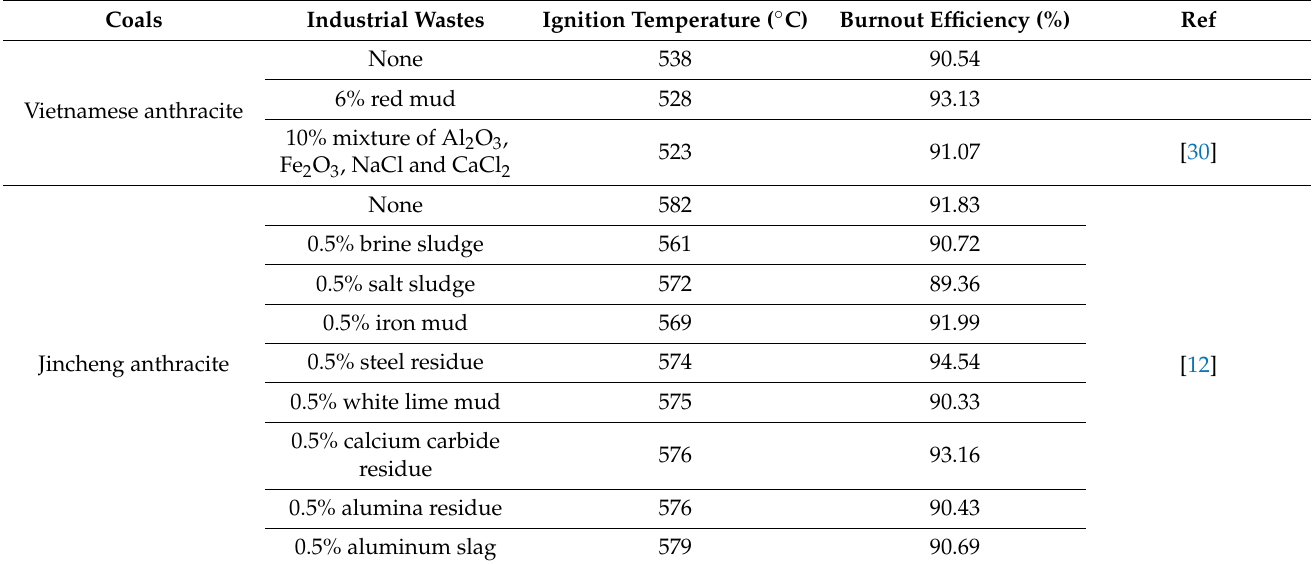
Table 3. Comparison of the effects of industrial wastes on the ignition temperature and burnout efficiency of Vietnamese anthracite and Jincheng